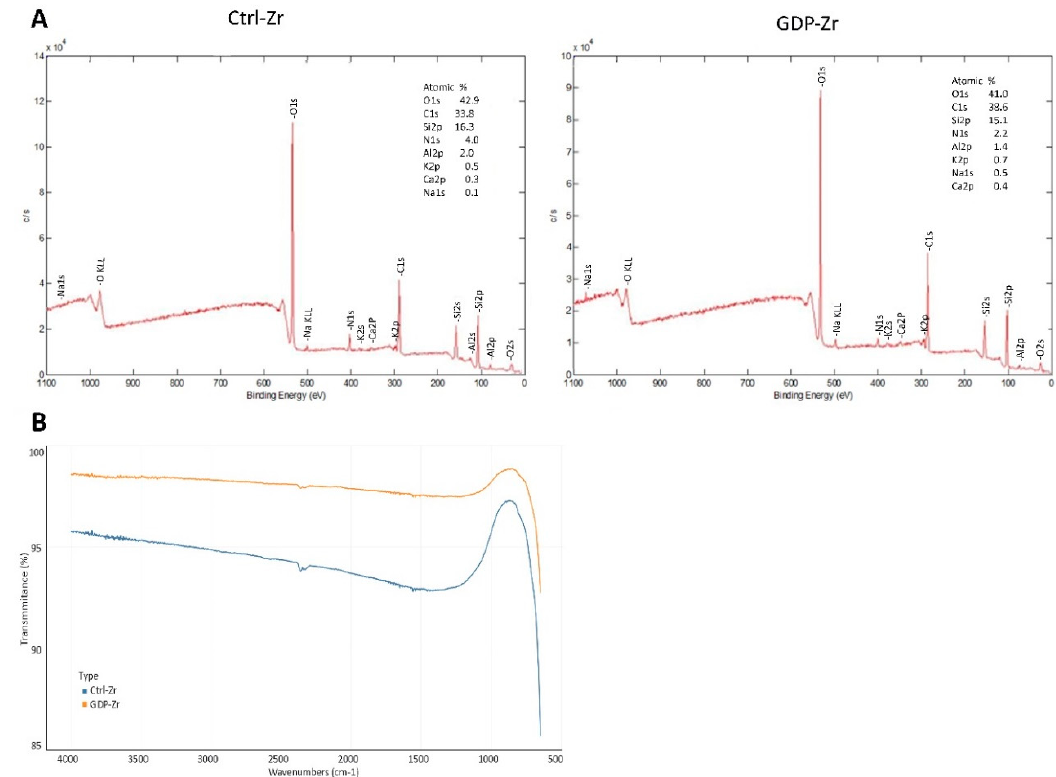
Figure 2. Surface properties were examined using XPS and FTIR analyses. ( A ) The XPS examination showed the surface characteristics of the sample. ( B ) Survey FTIR spectra indicating the atomic peaks of the treated samples. Ctrl-Zr, autoclaved disc; GDP-Zr, glow-discharge-plasma-treated disc.